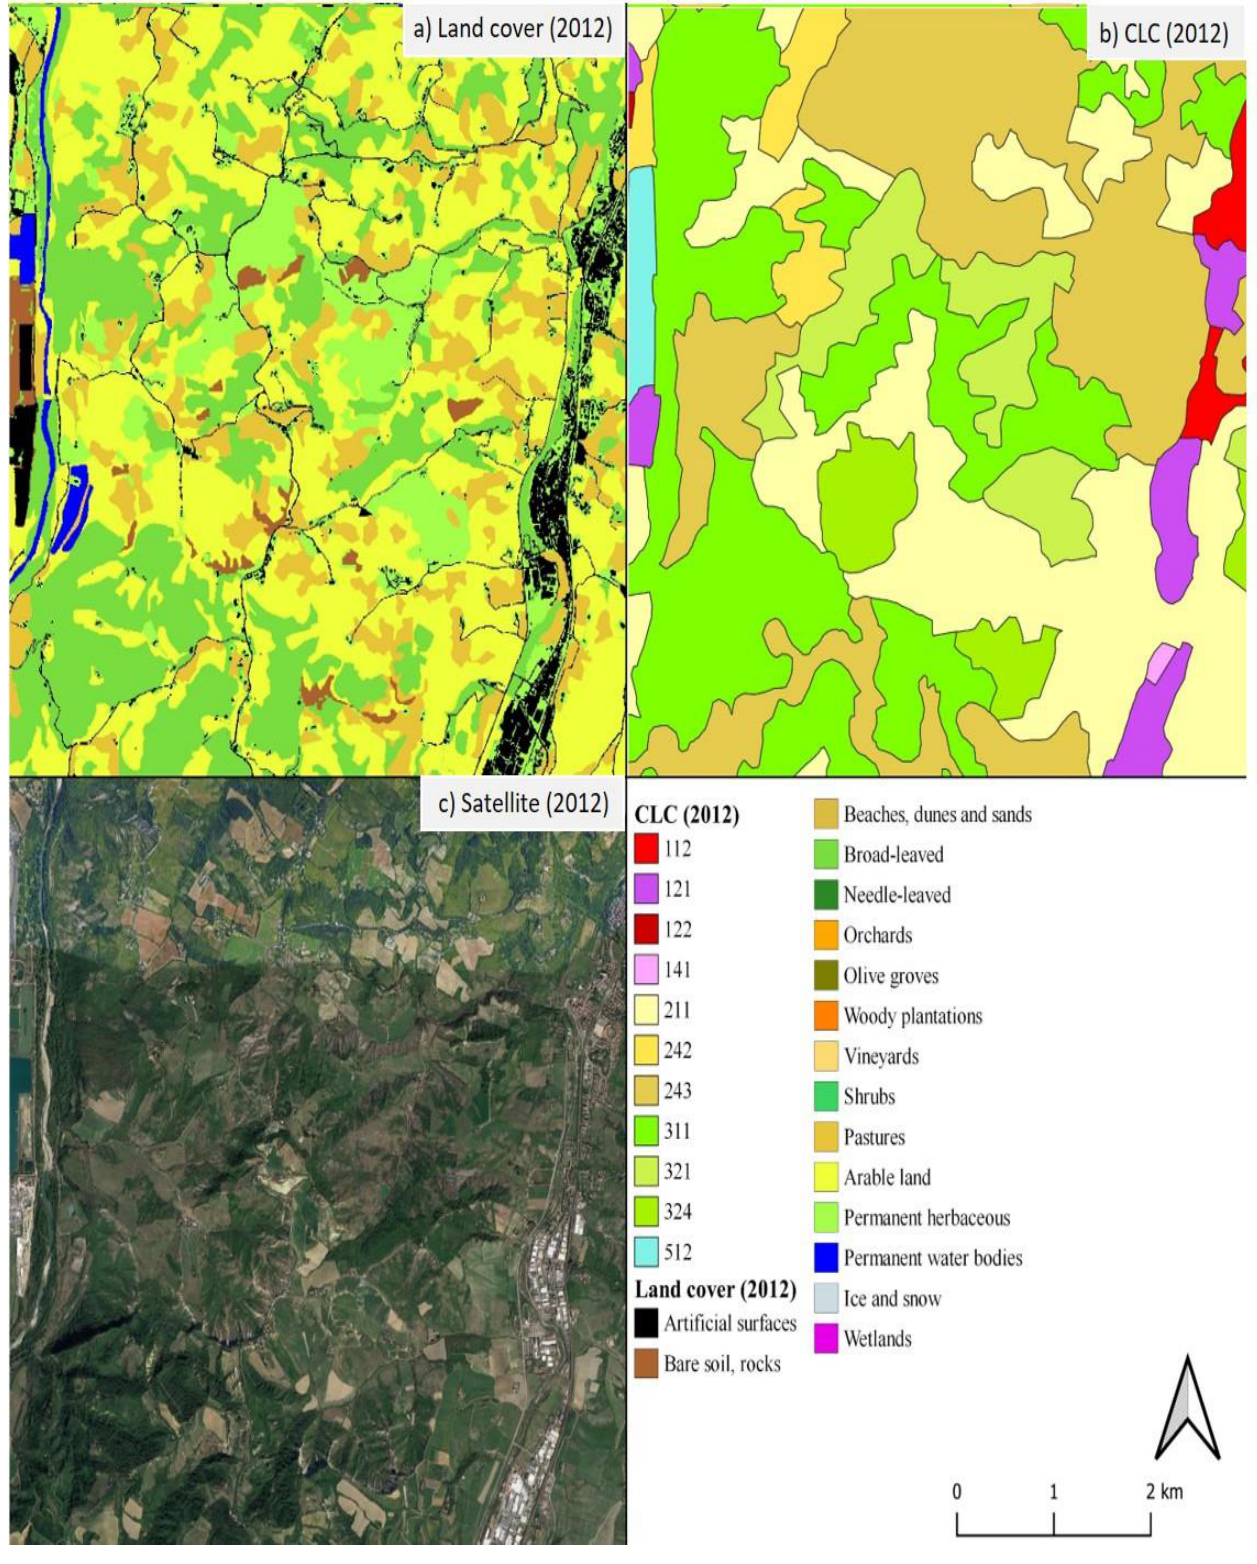
Figure 8. Comparison between land cover map for 2012 ( a ), CORINE Land Cover ( b ) and satellite image ( c ), focusing on small patches of natural vegetation and agricultural areas.